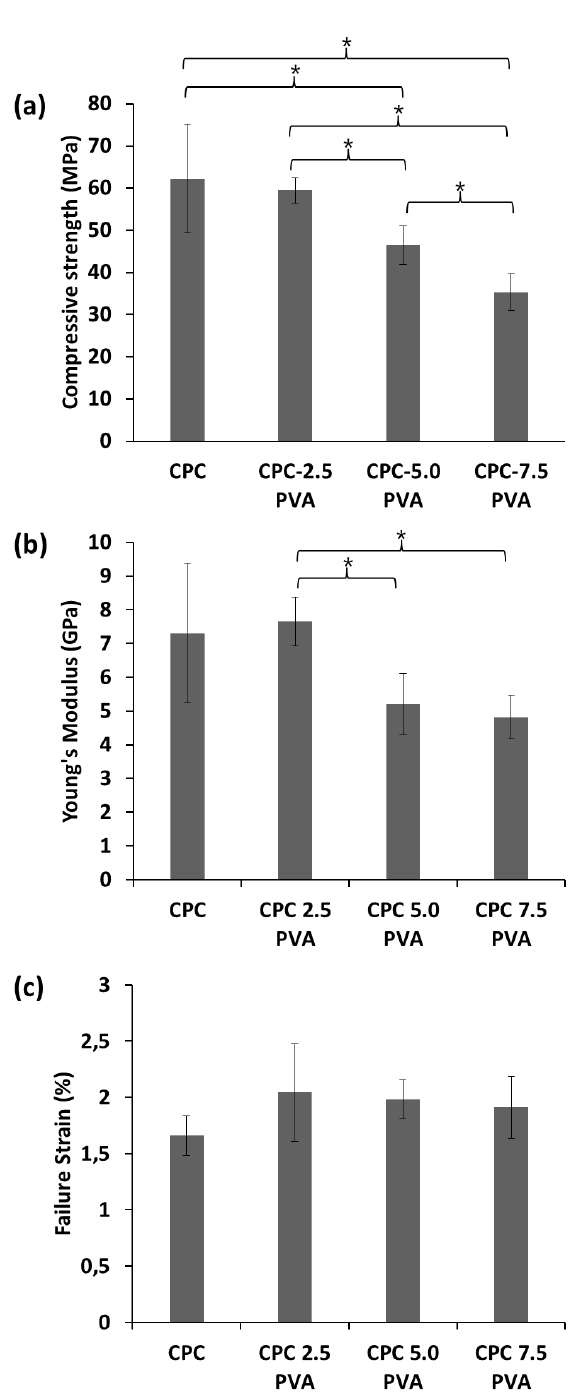
Figure 2. Mechanical properties of the cements from compressive strength (CS) tests. ( a ) Compressive strength; ( b ) Young’s modulus; ( c ) failure strain (taken at first load drop). * Statistically significant difference (ANOVA, Scheffe’s post-hoc test, p < 0.05).